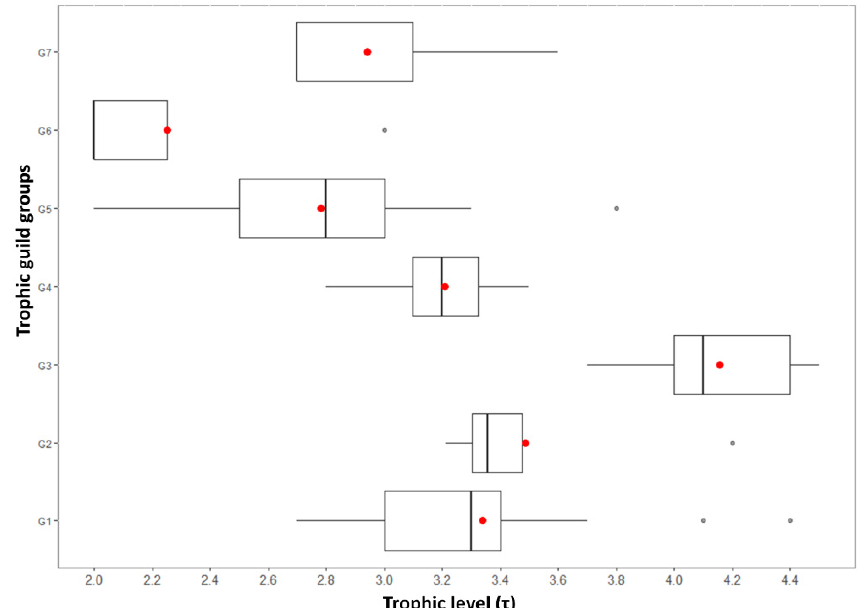
Figure 5. Box-and-whisker plots of the trophic level per trophic guilds (G1–G7) of the Greek fresh- water fish species (red dot: mean; vertical line: median; gray dots: outliers; G1: zooplanktivorous; G2: opportunistic piscivorous; G3: piscivorous, G4: insectivorous; G5: opportunistic zooplanktivorous; G6: herbivorous; G7: opportunistic detritivorous; N = 60).